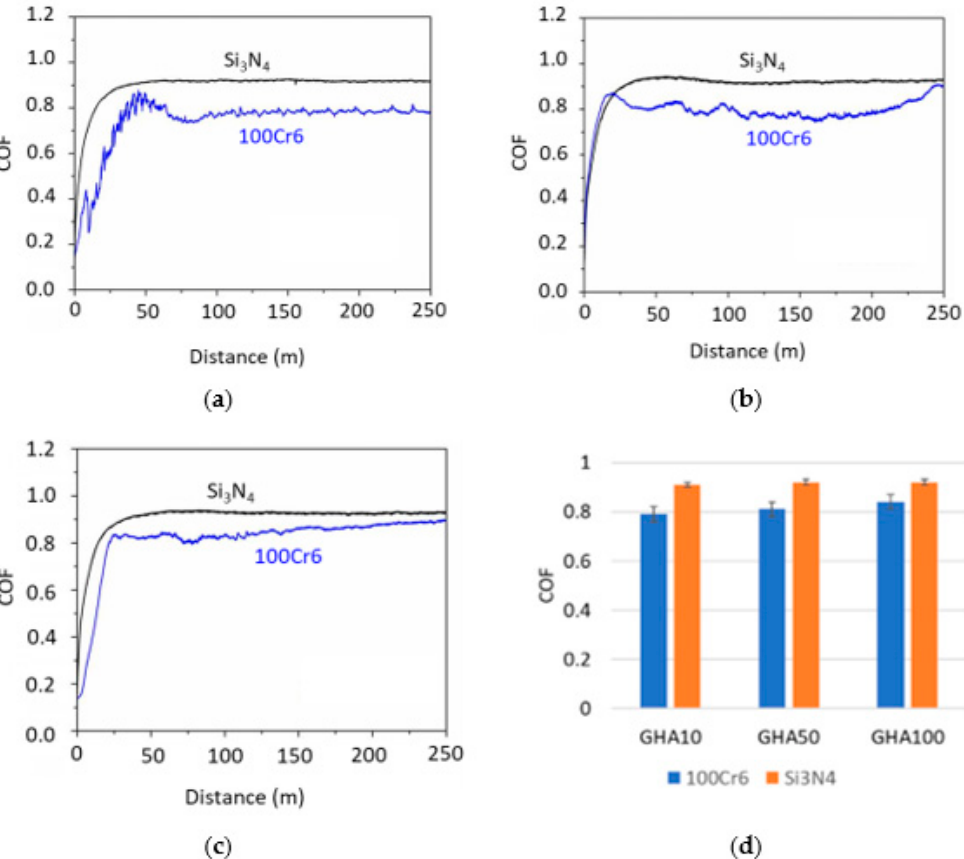
Figure 4. Friction coefficient evolution for ( a ) GHA10, ( b ) GHA50, ( c ) GHA10 and average friction coefficient (COF) values ( d ).